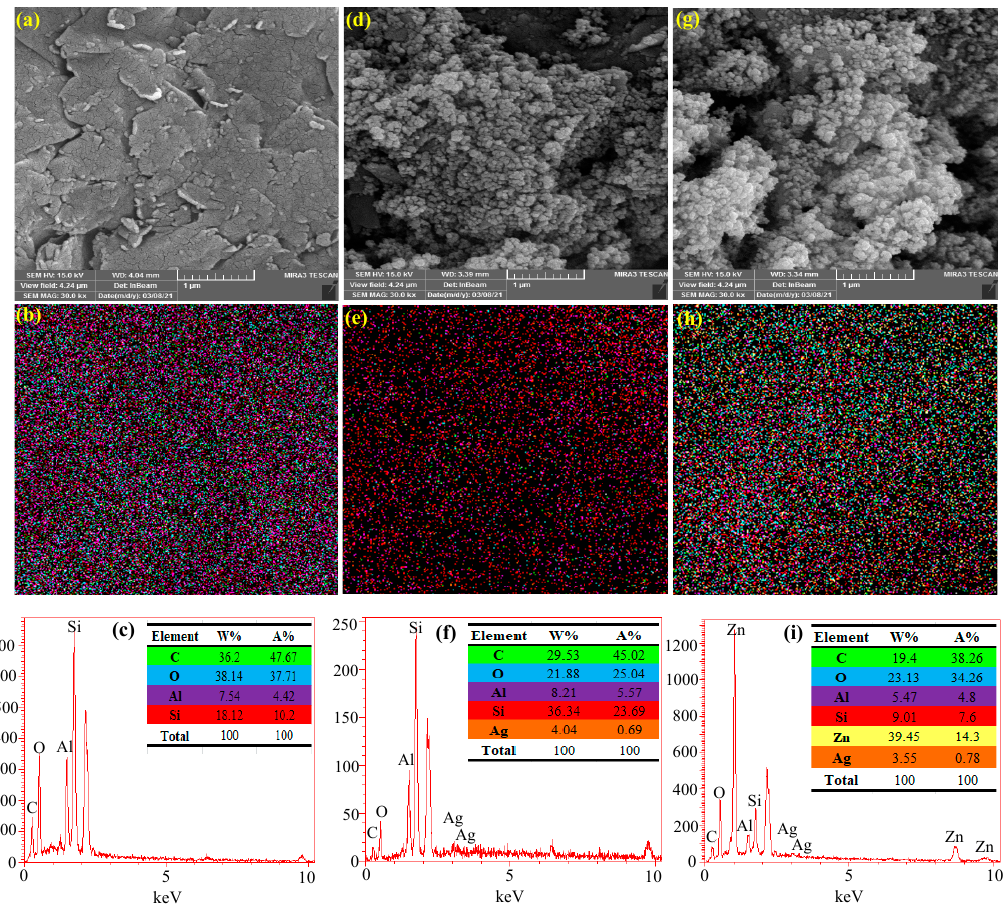
Figure 4. SEM and Map-EDX analysis for ( a – c ) Cloisite 30B, ( d – f ) ZnO, and ( g – i ) Cloisite 30B/ZnO/Ag 2 O.